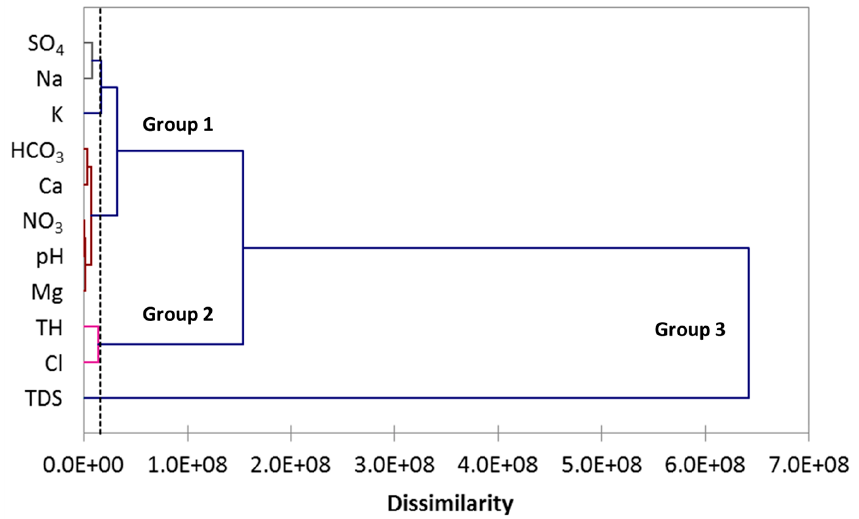
Figure 8. Cluster tree of the variables for water samples (measure: Pearson’s correlation coefficient;